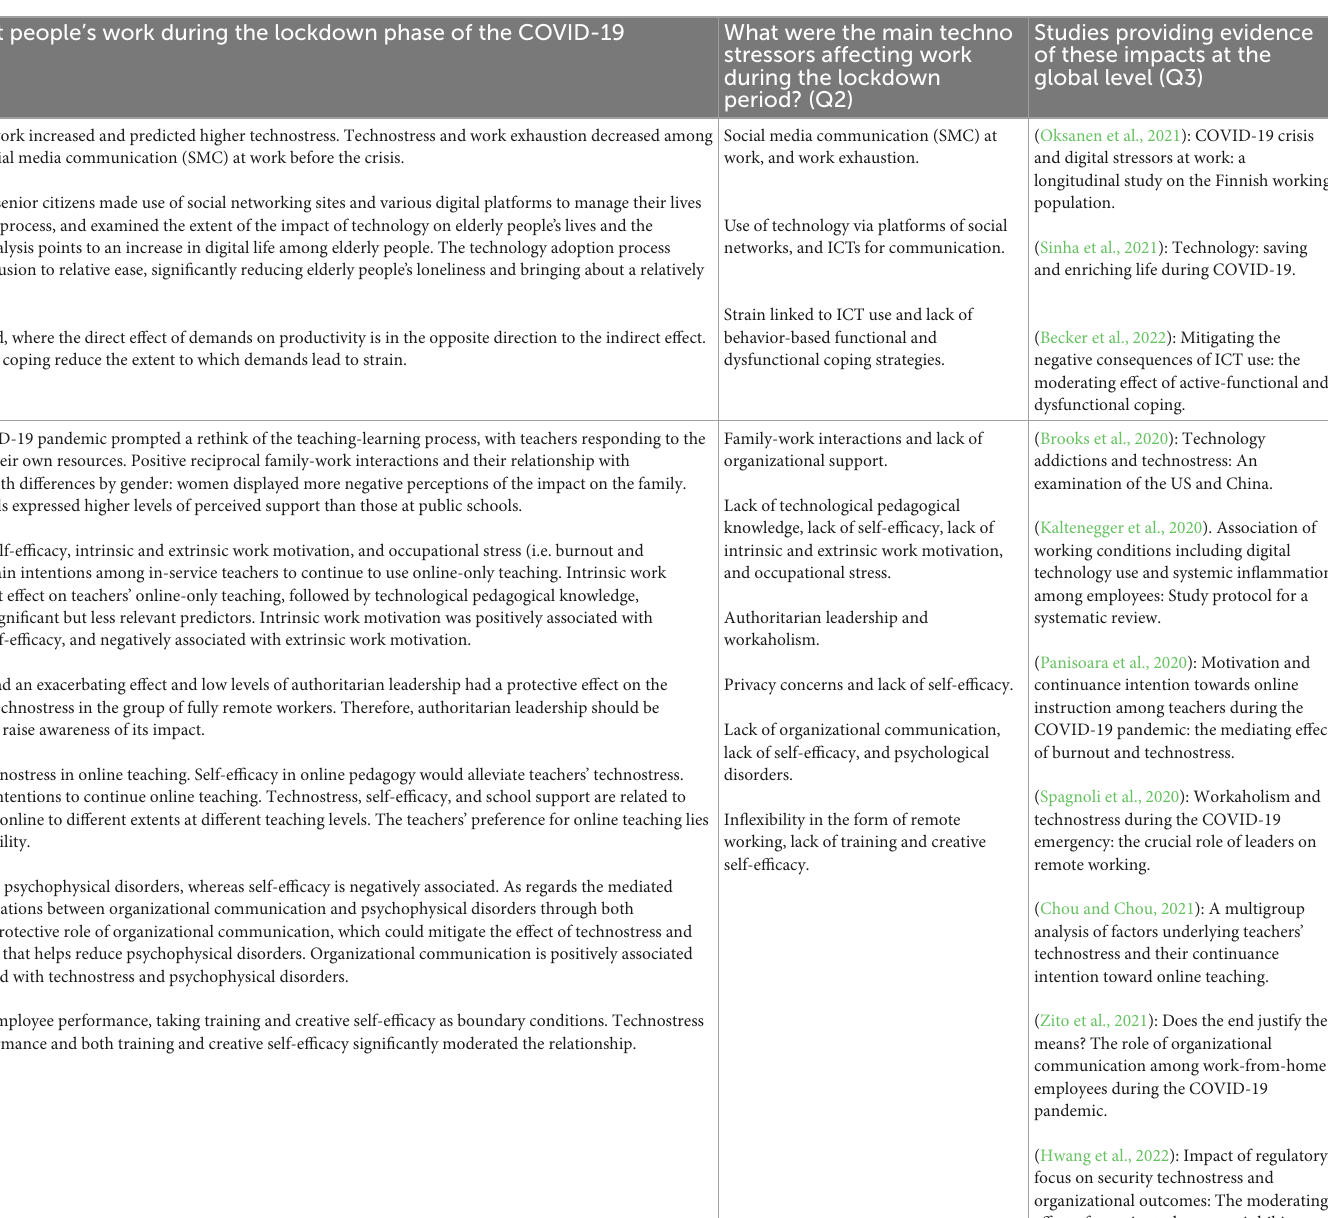
TABLE 3 Systematic review of articles with answers to our specific research questions. Group What were the main techno